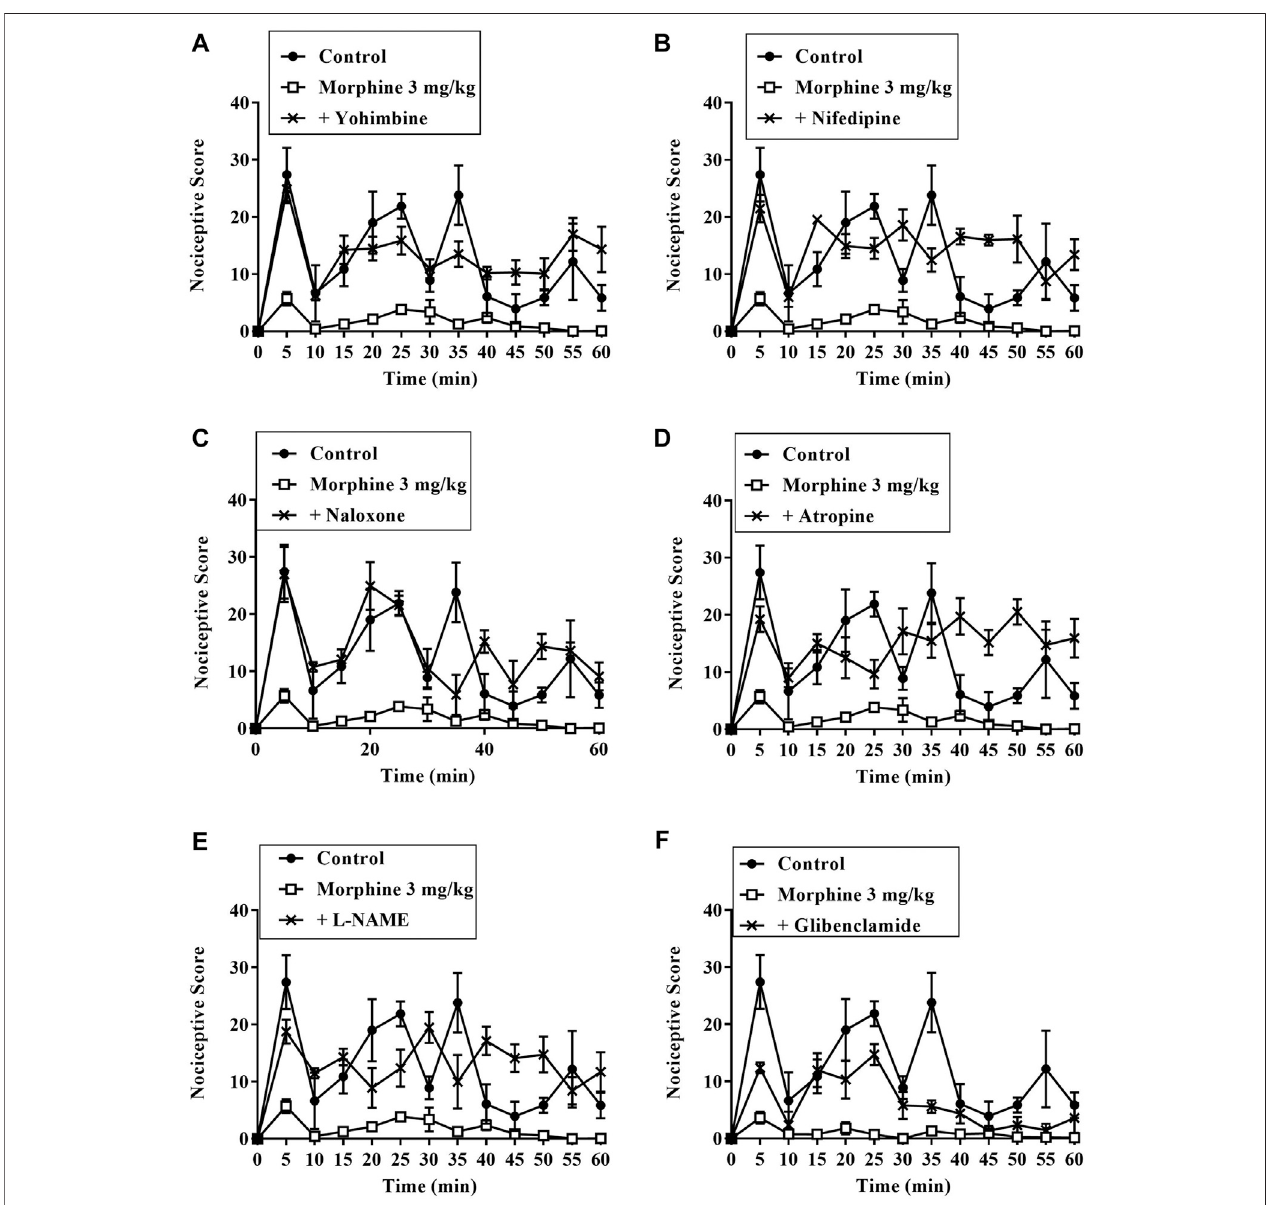
FIGURE 8 | Effect of pre-treatment of mice with (A) yohimbine (B) nifedipine (C) naloxone (D) atropine (E) L- NAME, and (F) glibenclamide on the anti-nociceptive pro fi le of morphine (3 mg/kg, p. o.) in phase 1 and phase 2 of formalin-induced nociception.